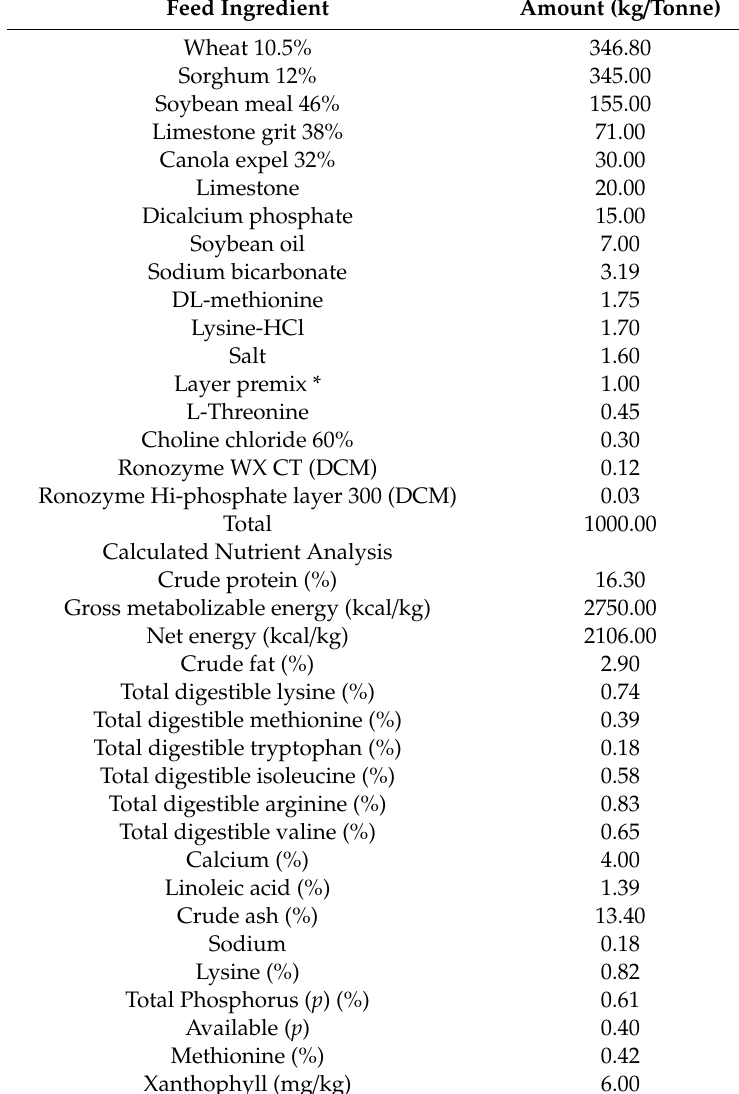
Table A1. Dietary composition of the experimental basal diet.